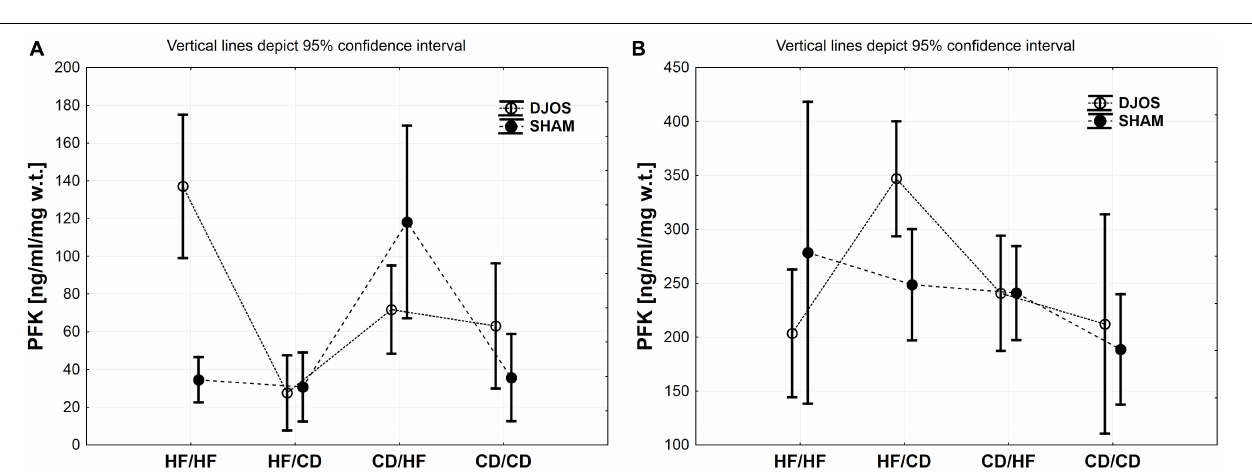
FIGURE 3 | (A) PFK (ng/ml/mg w.t.) muscle concentration in groups subjected to different dietary patterns, according to the DJOS and SHAM operation type. (B) PFK (ng/ml/mg w.t.) liver concentration in groups subjected to different dietary patterns, according to the DJOS and SHAM operation type. Statistical significance was set at a p < 0.05. Vertical lines depict 95% confidence interval. DJOS, duodenal-jejunal omega switch surgery; HF, high fat diet; CD, control diet; HF/HF, CD/HF, HF/CD, CD/CD, type of diet 8 weeks before/8 weeks after